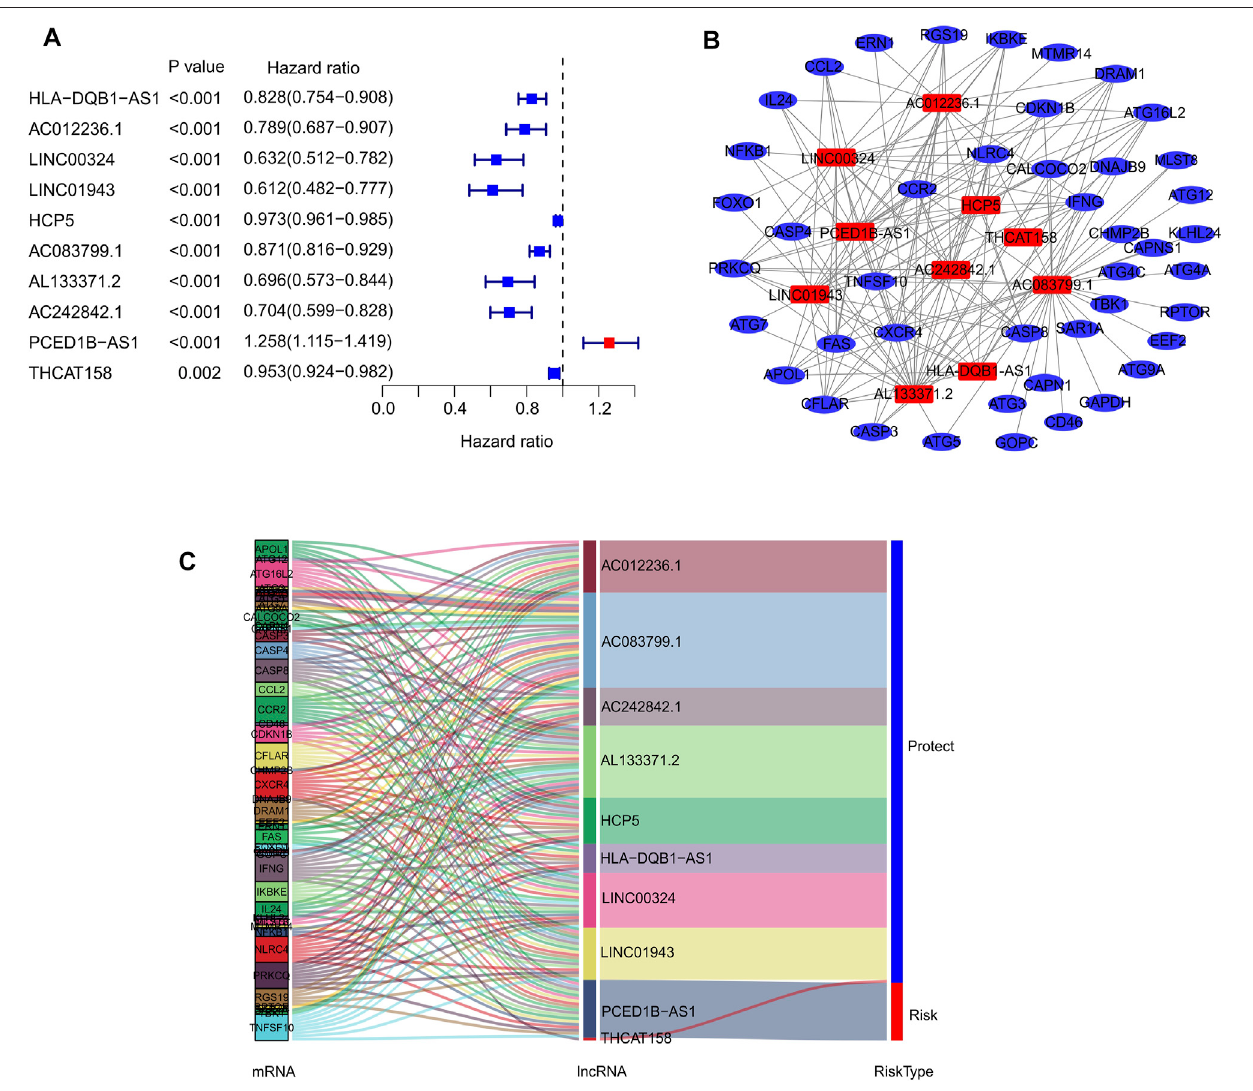
FIGURE 1 | Identi fi cation of prognostic autophagy-related lncRNAs. (A) Multivariate Cox analysis of prognostic autophagy-related lncRNAs. (B) Network analysis of autophagy related lncRNAs and autophagy mRNAs. (C) The Sankey diagram shows the connection degree between autophagy mRNAs and autophagy-related